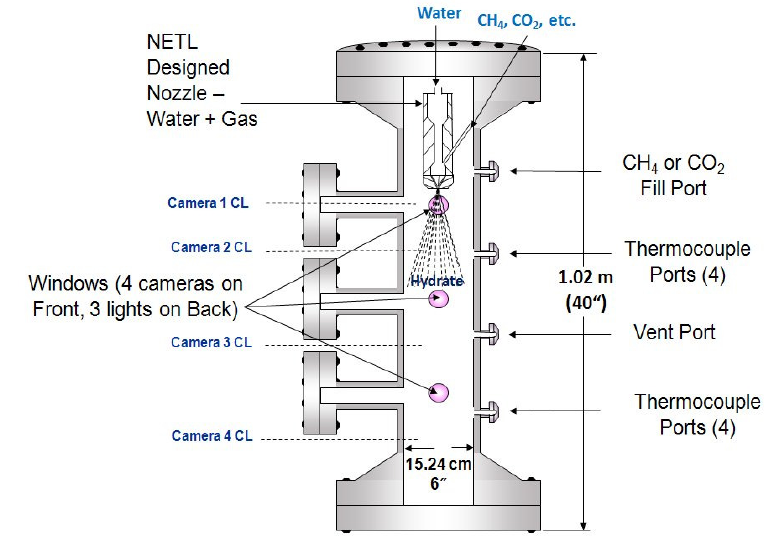
Figure 11. NETL 15-Liter Hydrate Cell; horizontal installation with viewports (4 Cameras) along equator, and numerous instrumentation ports throughout the